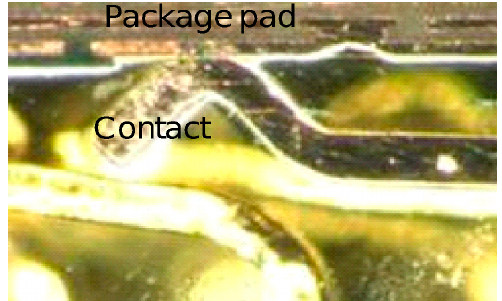
Figure 10. Contact force distribution under step load only.